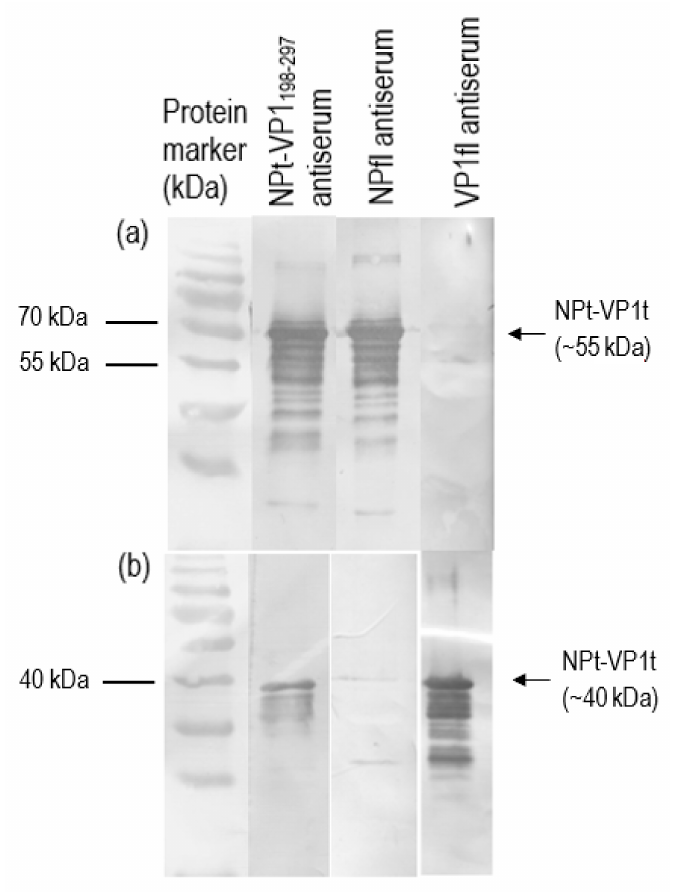
Figure 11. Western blot analysis using antisera of NPt-VP1 198–297 protein against ( a ) NPfl and ( b ) VP1fl antigens. Each antiserum was diluted with 1X TBS in 500 X dilution and incubated with the antigen-coated membranes for 1